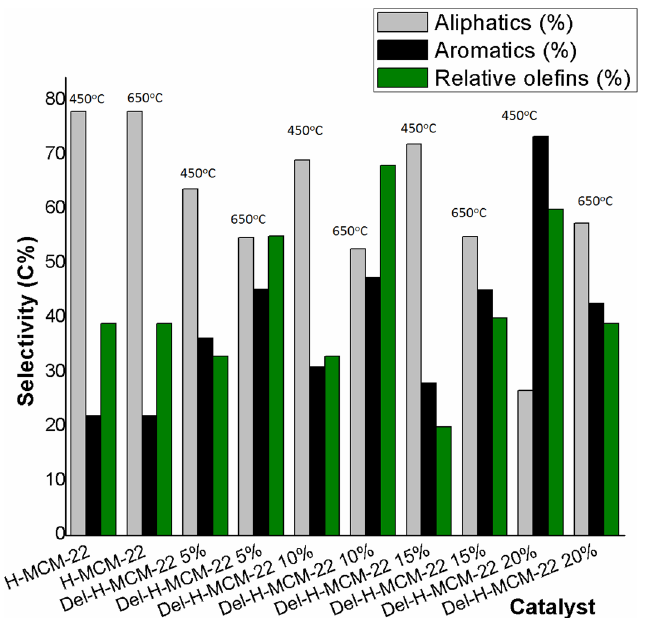
Figure 7. Comparison of aliphatic, aromatic and relative olefinic selectivity over prepared catalysts at 450 °C and 650